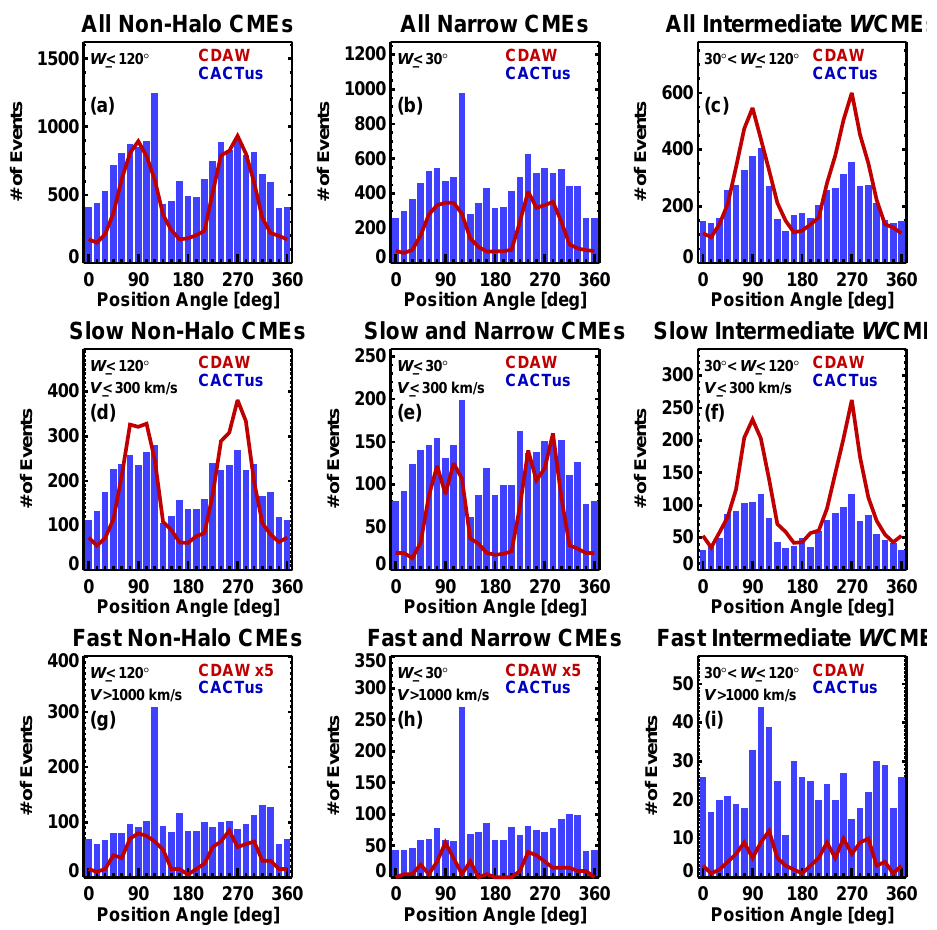
Fig. 5. Central position angle distributions of (a) all non-halo CMEs, (b) fast non-halo CMEs, (c) narrow CMEs, and (d) fast and narrow CMEs, which are listed in CACTus (blue bars) and CDAW (red lines) catalogs. The numbers of fast CDAW CMEs (panels g and h ) are multiplied by 5. The anomaly peaks in CACTus are shown in 120 ◦ bin, which correspond to the coronagraph pylon of LASCO.